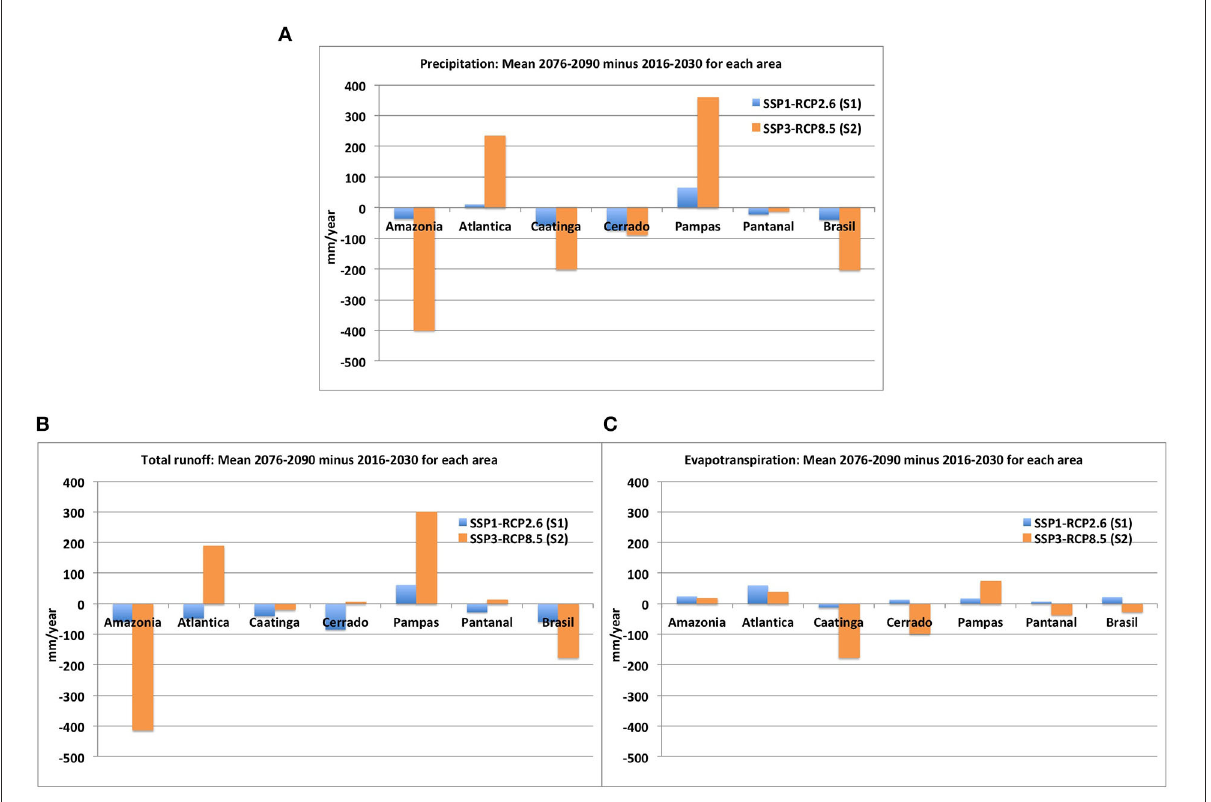
FIGURE3 Difference (mm/year) between the mean of the last and first 15 years of the simulation for each biome for (A) precipitation, (B) total runoff, and (C) evapotranspiration for S1 (blue bars) and S2 (orange bars).